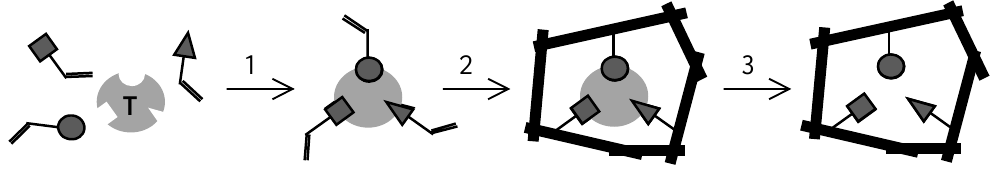
Figure 1 . Schematic representation of the molecular imprinting process (T = Template; 1 = Assembly; 2 = Polymerization; 3 = Template